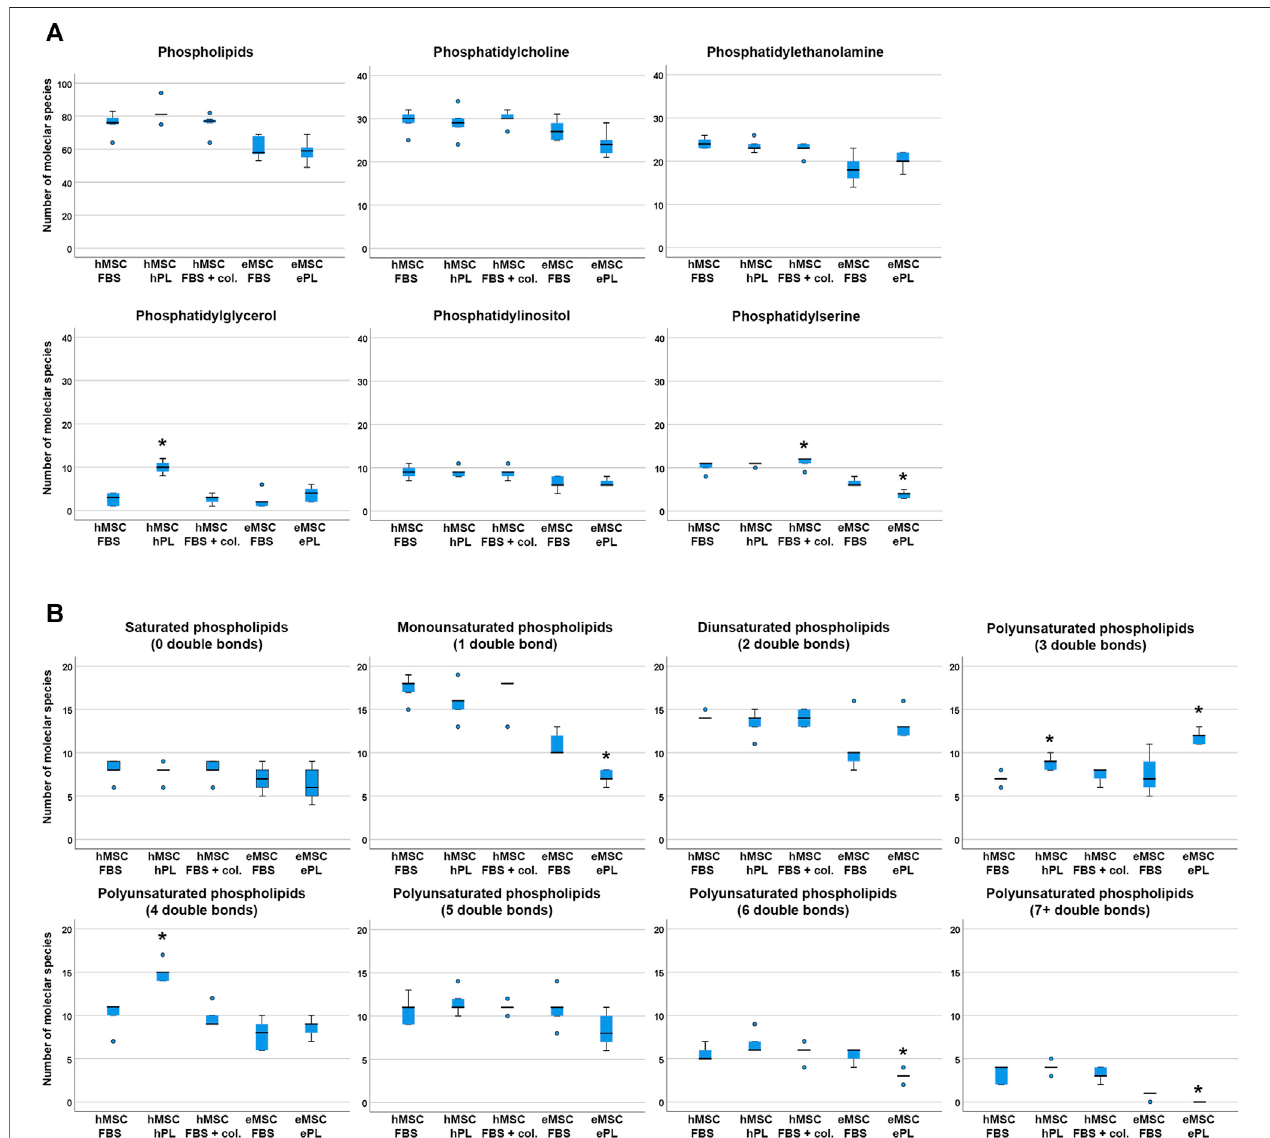
FIGURE 2 | Phospholipid species diversity across MSC cell culture conditions. Panel A boxplots represent the numbers of either total phospholipid molecular species or the numbers of phospholipid species within the different phospholipid classes. Panel B boxplots represent the numbers of phospholipid molecular species within lipid groups by extent of saturation. Asterisks indicate signi fi cant differences ( p ≤ 0.050) between the respective MSC group as compared to MSC from the same species cultured in standard conditions (i.e., with FBS). Data were obtained from n (cid:1) 5 donors in all groups and donors from the same species were paired.